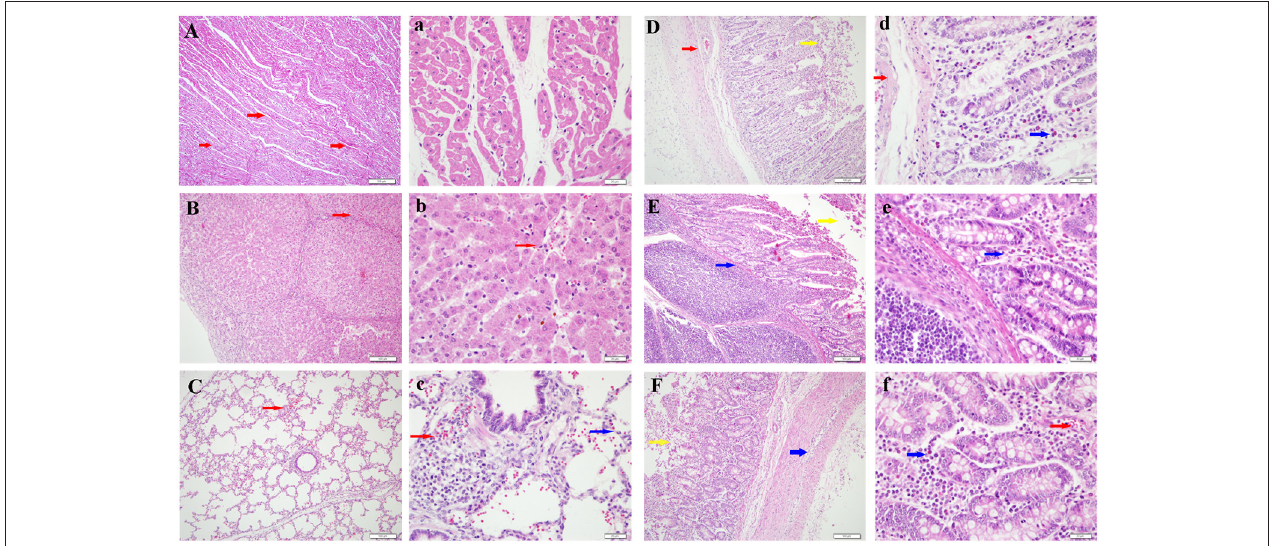
FIGURE 3 | Histological changes in different tissues induced by Senecavirus A (SVA) infection. ( A,a ) Enlargement of the myocardial fiber space, cellular vacuolation, and hemorrhage in the heart (red arrow). ( B,b ) Eosinophilic lesions, cytoplasmic concentration, and scattered distribution of red blood cells (red arrow) in the liver. (C,c) Emphysema, congestion (red arrow), and inflammatory cell infiltration (blue arrow) in the lung. Abscission of intestinal epithelial cells (yellow arrow), inflammatory cell infiltration (blue arrow) in the lamina propria, and minor bleeding (red arrow) were observed in the jejunum (D,d) , ileum (E,e) , and duodenum ( F,f ). Bar, (A–F) : 100 µ m; (a–f) : 20 µ m.